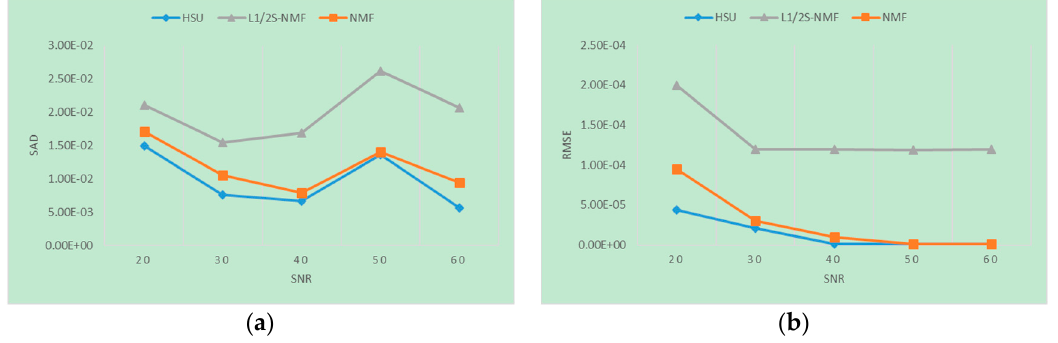
Figure 9. SNR effects on SAD and RMSE: ( a ) SAD and ( b ) RMSE.